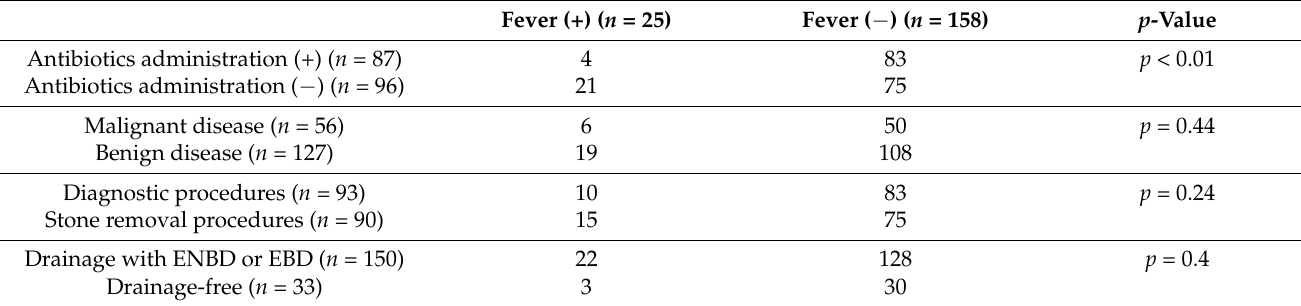
Table 7. Analysis of risk factors for a fever of higher than 38.0 ◦ C on the day after the